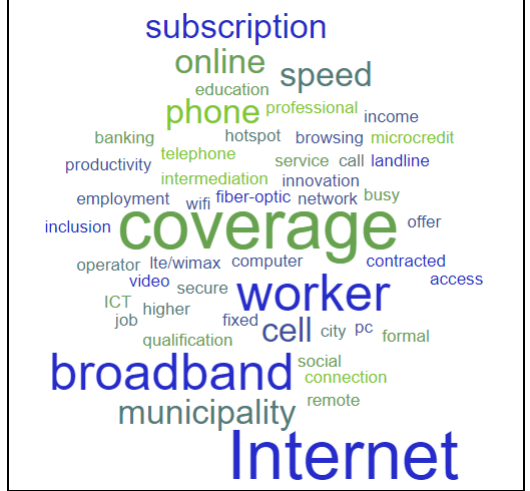
Figure 18. Most frequent indicators within the theme of “technology and innovation”.